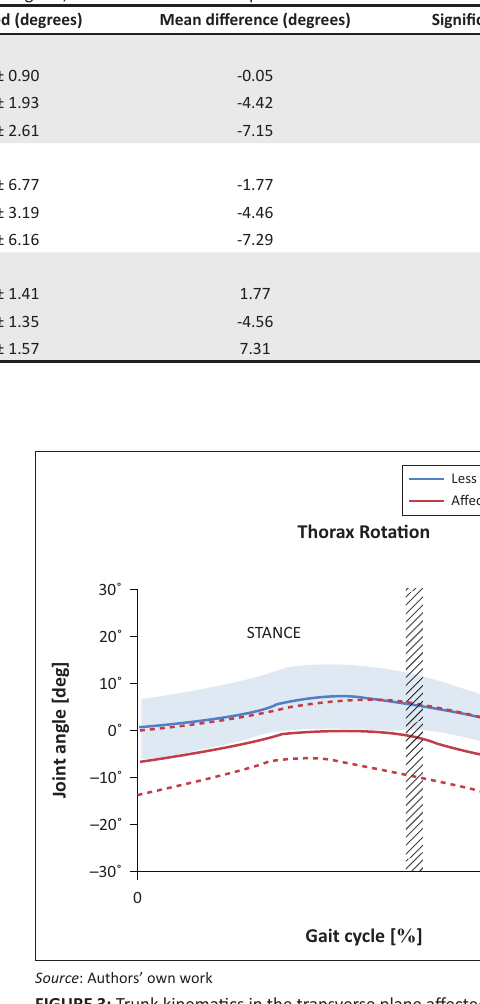
FIGURE 3: Trunk kinematics in the transverse plane affected versus unaffected.